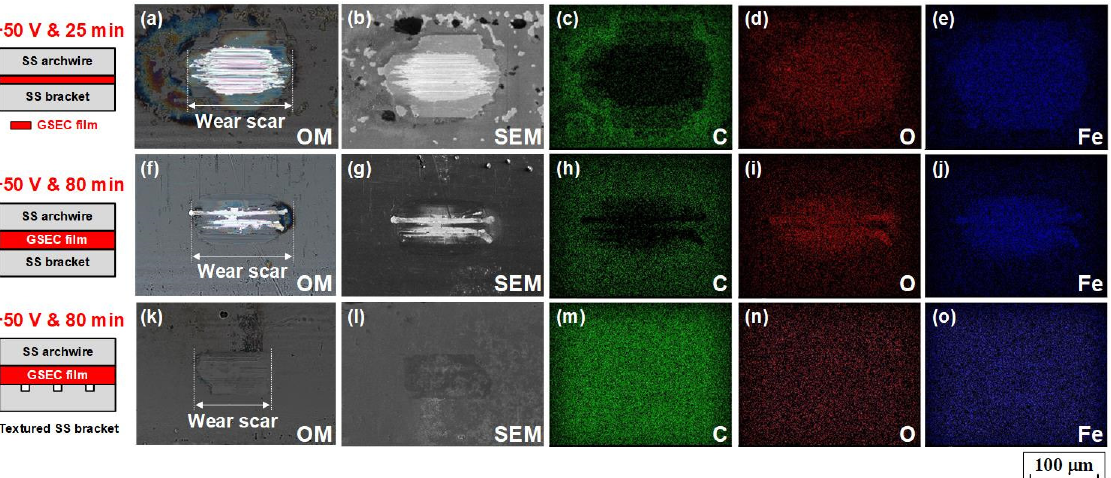
Figure 7. Surface characterizations of the wear scars on the GSEC film-coated stainless steel (SS) archwires after sliding against untextured and three-row groove textured stainless steel brackets in artificial saliva environment. ( a – e ) Wear scar on the GSEC film (+50 V and 25 min) coated archwire after running against untextured bracket. ( f – j ) Wear scar on the GSEC film (+50 V and 80 min) coated archwire after running against untextured bracket. ( k – o ) Wear scar on the GSEC film (+50 V and 80 min) coated archwire after running against three-row micro-groove textured bracket. ( a , f , k ) Optical microscopy images and ( b , g , l ) SEM images of the wear scars on the archwires. ( c , h , m ) carbon element, ( d , i , n ) oxygen element, and ( e , j , o ) ferrum element distributions of the wear scars on the archwires. Illustrations of three contact models are also shown for reference.